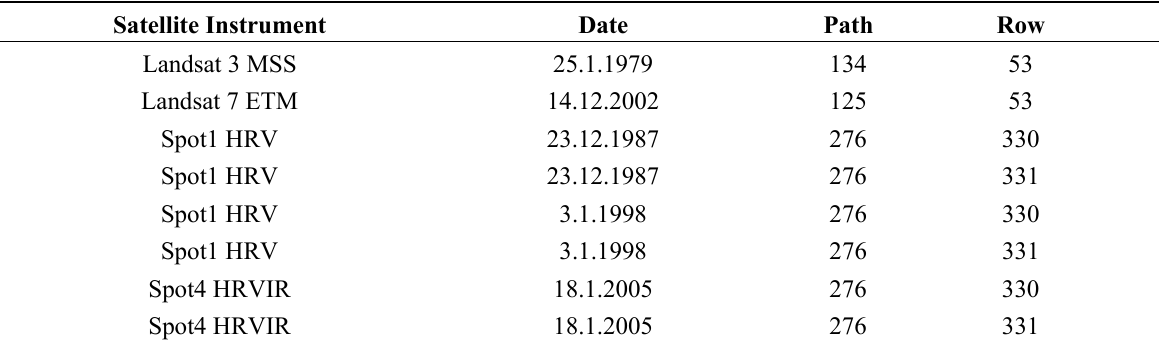
Table 2. The list of optical satellite